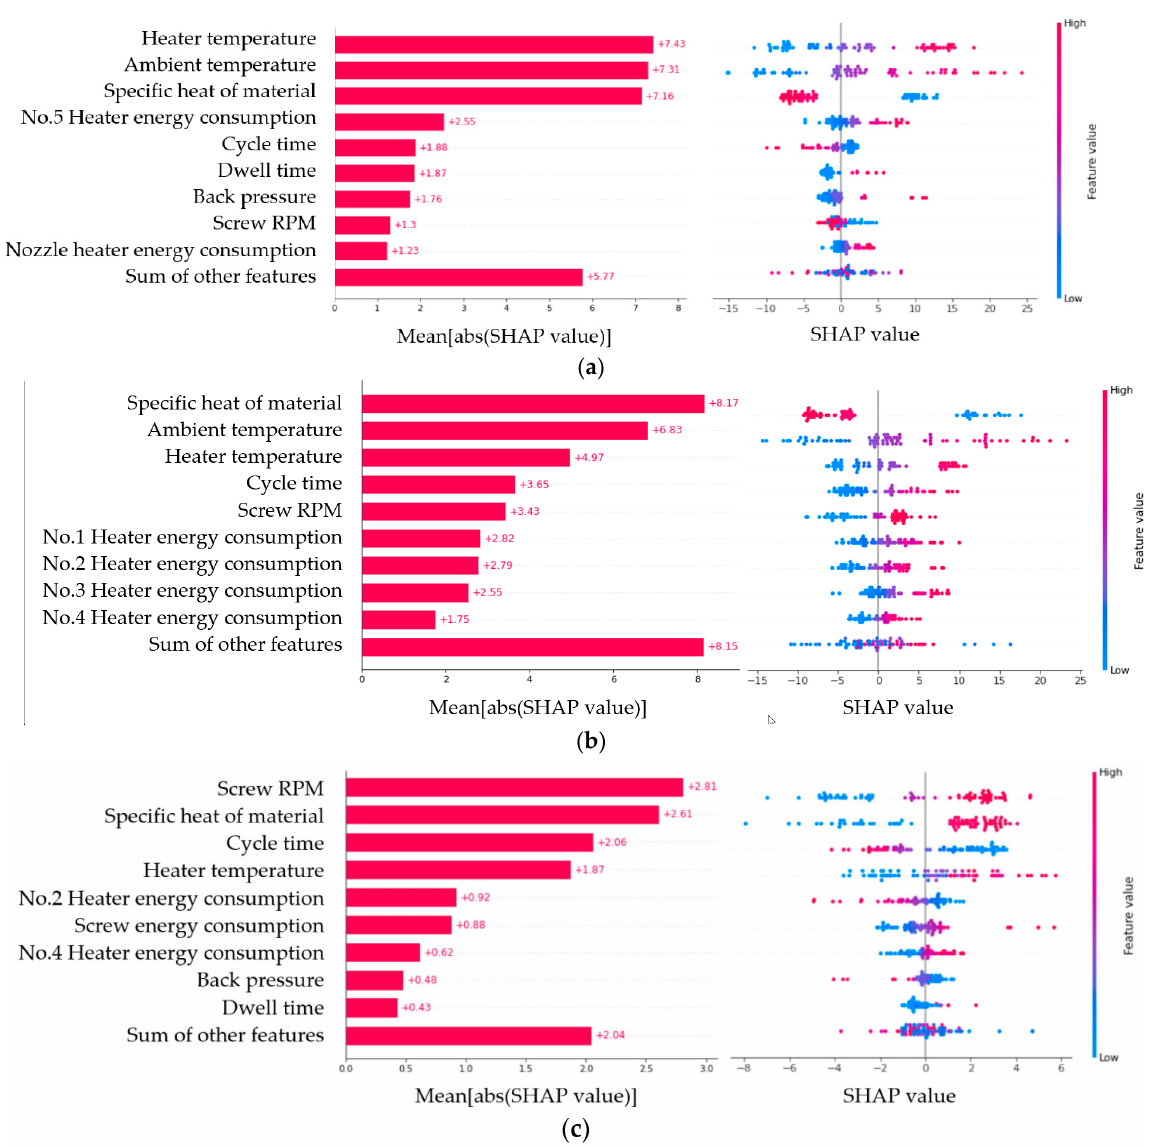
Figure 13. SHAP values for the ( a ) initial, ( b ) maximum, and ( c ) max–min difference temperature